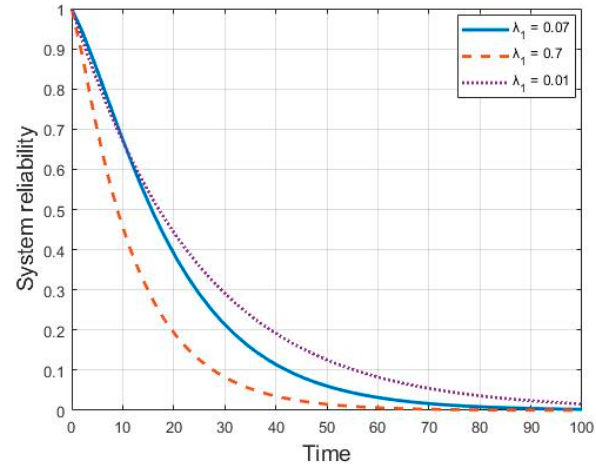
Figure 4. System reliability comparison with the changes of degradation rate λ 1